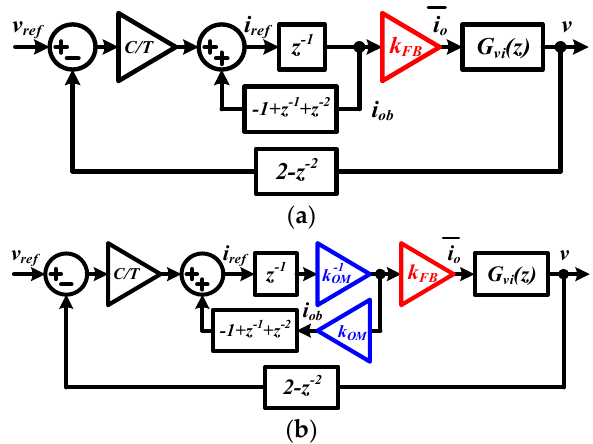
Figure 12. Discrete-time small signal models with consideration of current damping. ( a ) SCB control, ( b ) OSCB control.